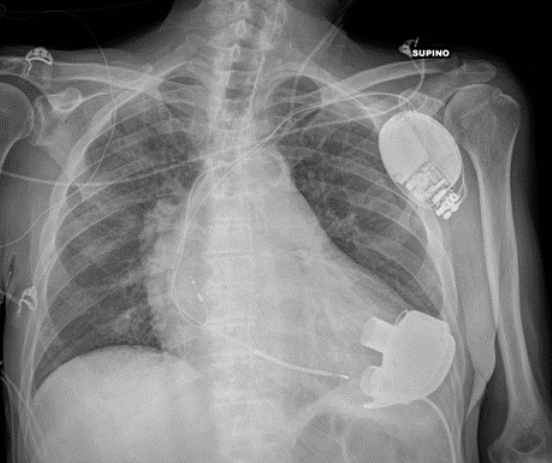
Figure 15. Properly positioned LVAD. The image also shows an AICD, a left jugular CVC and a nasogastric tube.